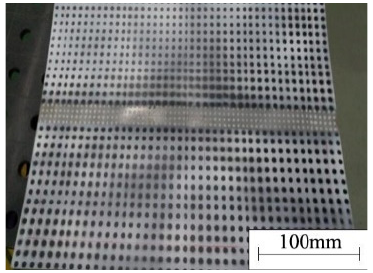
Figure 3. Test piece sprayed with high-temperature speckle. Table 1. The physical performance parameters of C-3 adhesive.